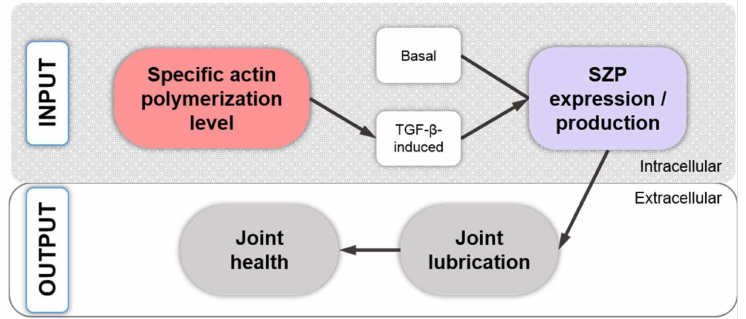
Figure 10. The specific range of actin polymerization causes TGF- β -induced superficial zone protein (SZP) production that results in joint lubrication and